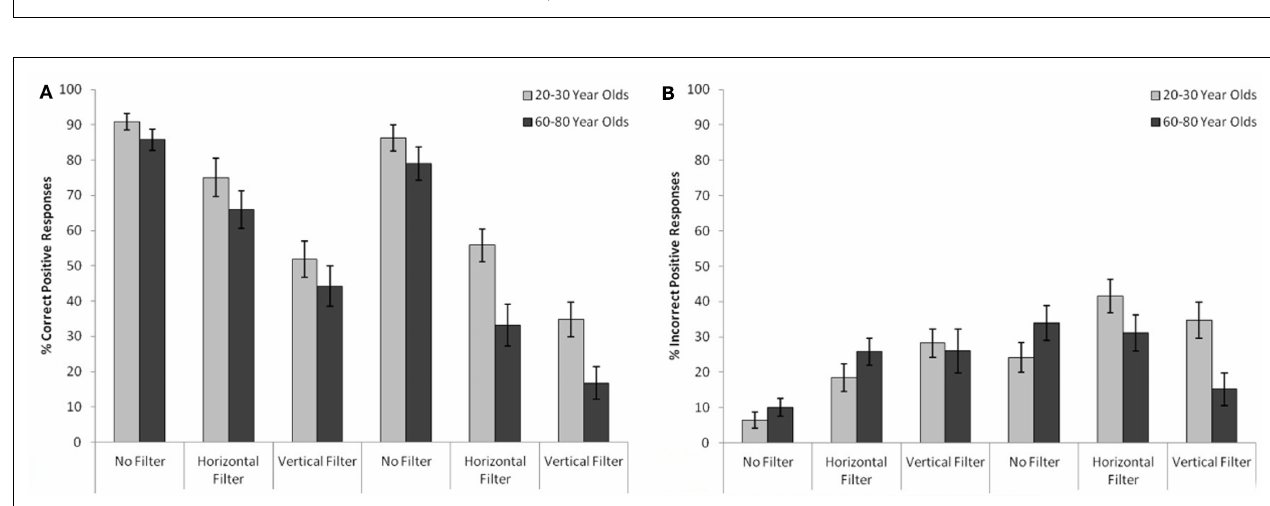
FIGURE 4 | (A) Hit rates. Amount of correct “yes” responses for both age groups for different stimulus types (B) false alarm rates. Amount of incorrect “yes” responses for both age groups for different stimulus